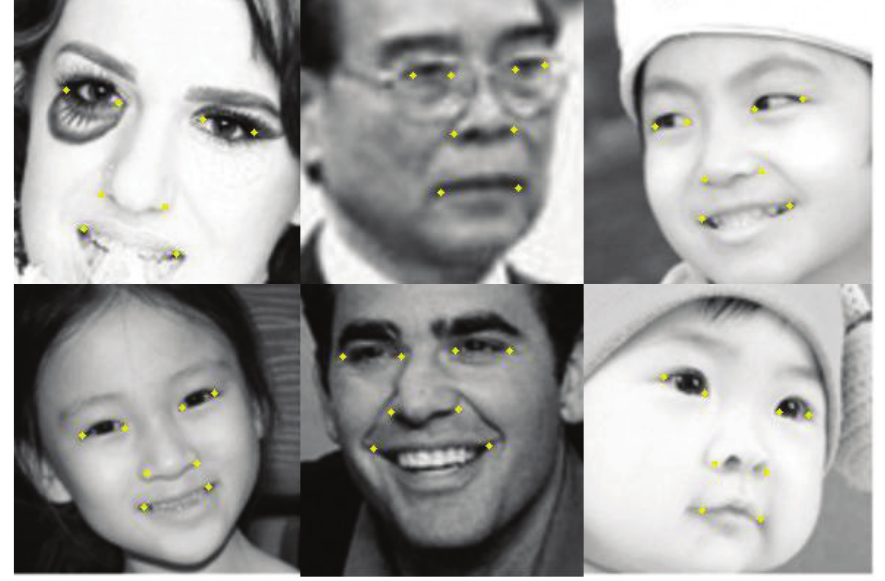
Fiducial point localization with pose changes, as well as variations on age, expression and